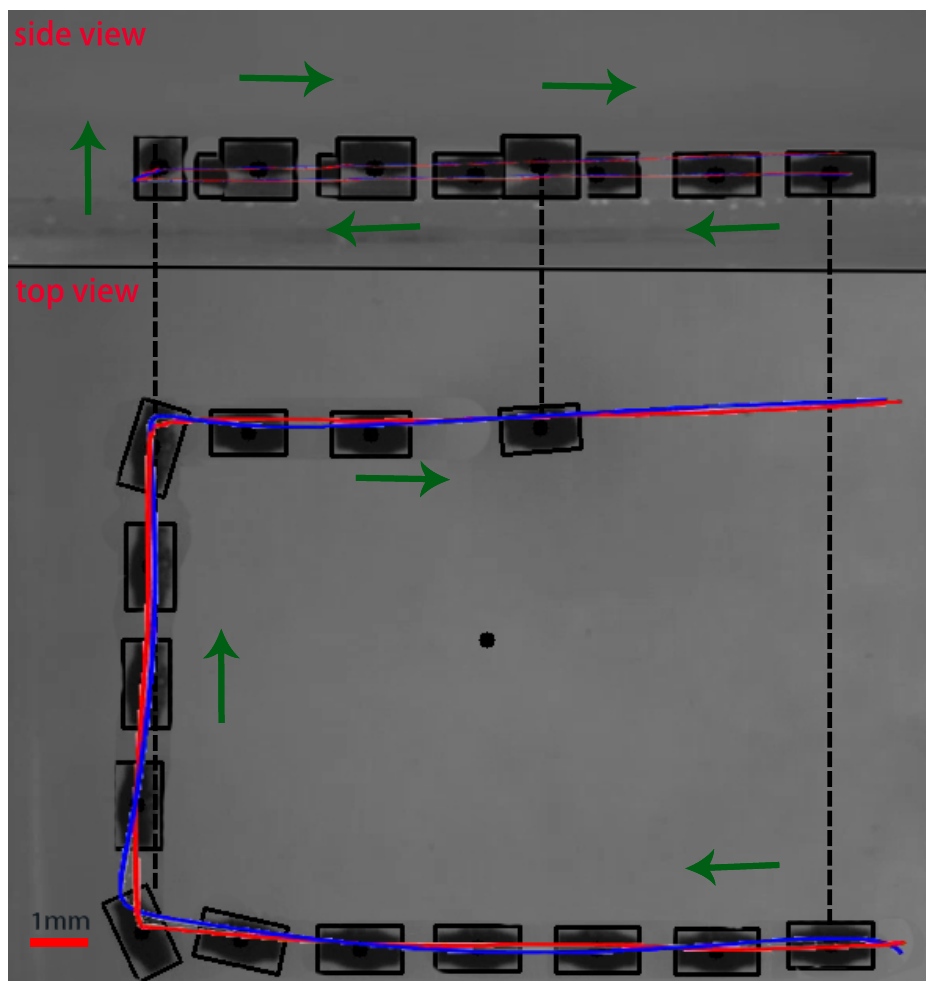
Figure 10. Demonstration of visual feedback control and the magnetic carrier completes a “mountain climbing” movement. Average trajectory-completion time: 23.43 s. The figure indicates the captured image in real-time that was processed gradation conversion, Gaussian filtering, binarization, expansion processing, finding contours and locating the contour center point. The blue line represents the predesigned trajectory, the red line represents the actual trajectory, and the green arrow represents the direction of movement of the magnetic